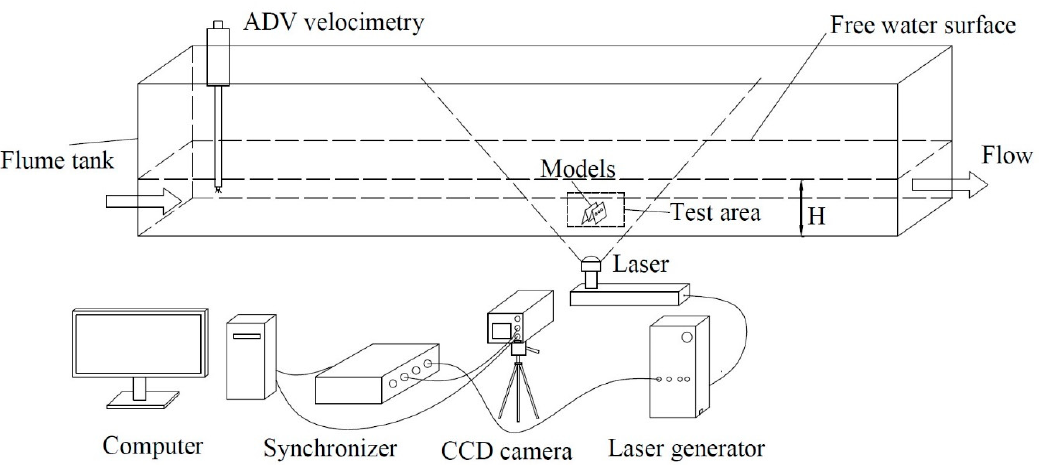
Figure 3. Experimental setup and Particle Image Velocimetry (PIV) system installation.